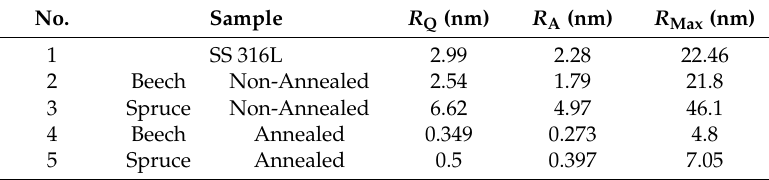
Table A3. Roughness parameters obtained from AFM measurements for studied